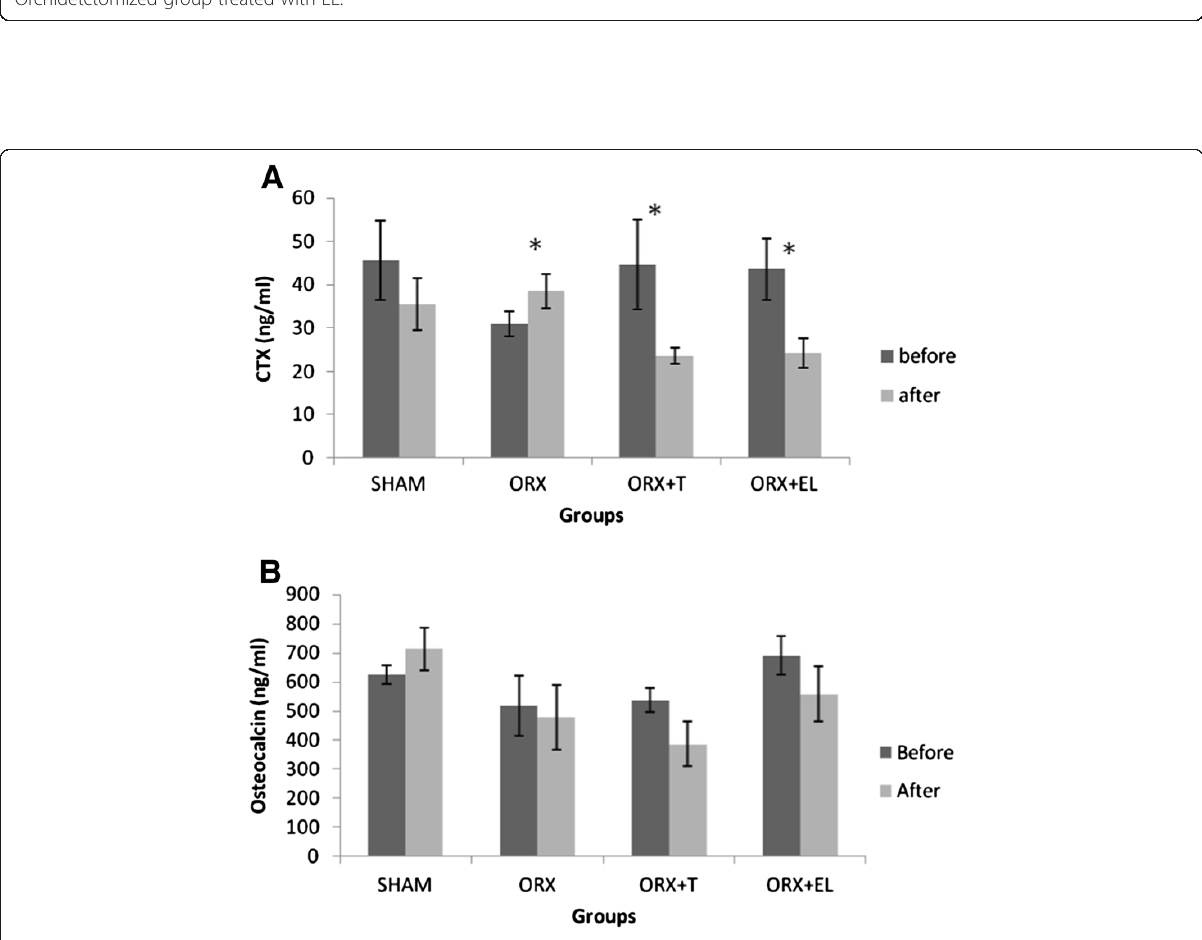
Figure 3 A and B The serum C-terminal telopeptide of type 1 collagen (CTX) and osteocalcin levels before and after treatment for all the groups. Data were presented as mean ± SEM with significant difference p < 0.05. *indicate significant difference before and after treatment. SHAM : Sham- operated group. ORX : Orchidectomized control group. ORX + T : Orchidectomized group treated by testosterone. ORX + EL : Orchidetctomized group treated with